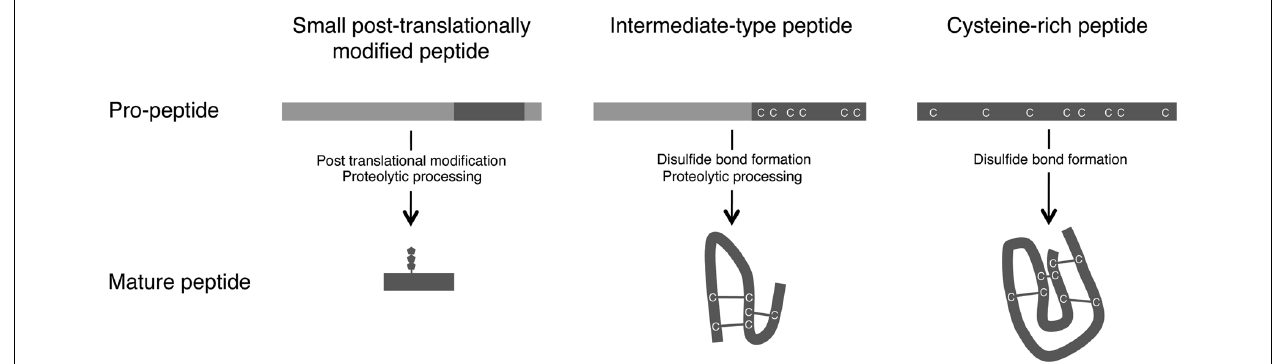
FIGURE 1 | Maturation processes of small secreted peptides. Based on their post-translational modification and processing from pre-propeptides, small secreted peptides in plants are divided into three groups: small post-translationally modified peptides, cysteine-rich peptides, and intermediate-type peptides (Matsubayashi, 2011; Murphy etal.,